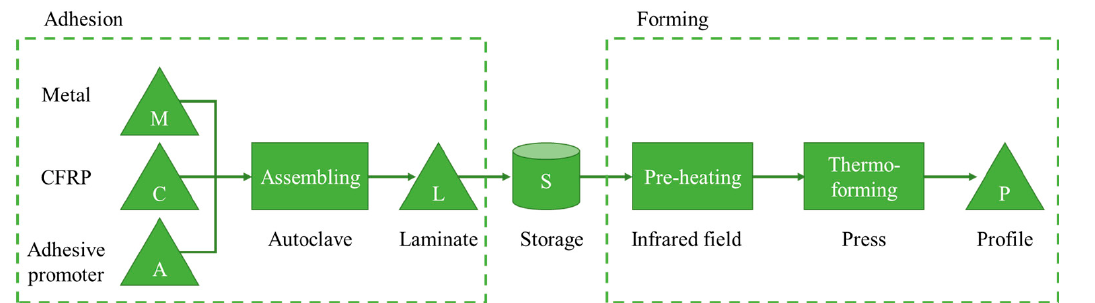
Figure 2. Conceptual flowchart of the adhesion and forming process.